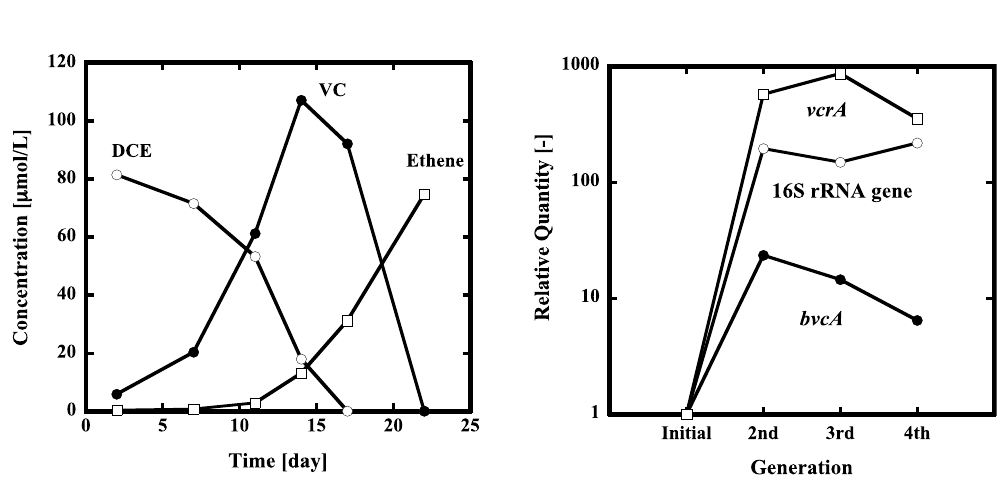
Figure 1. Construction of a bacterial consortium that dechlorinates cis -DCE to ethane. ( A ) Reductive dechlorination of cis -DCE to ethene by the 4 th -generation consortium. DCE (open circle), VC (closed circle), and ethene (open square). ( B ) Increase in Dehalococcoides spp. in the culture-by-culture generation. Relative amounts of the Dehalococcoides 16S rRNA, vcrA and bvcA genes were monitored by real time qPCR. Dehalococcoides 16S rRNA (open circle), bvcA (closed circle), and vcrA (open square)